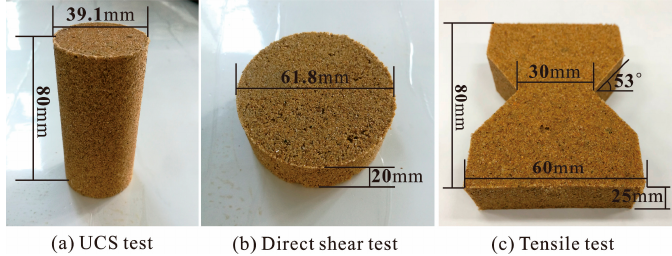
Figure 3. Photo of three tests reinforced specimens: ( a ) Unconfined compression strength (UCS) test; ( b ) Direct shear test; ( c ) Tensile test.